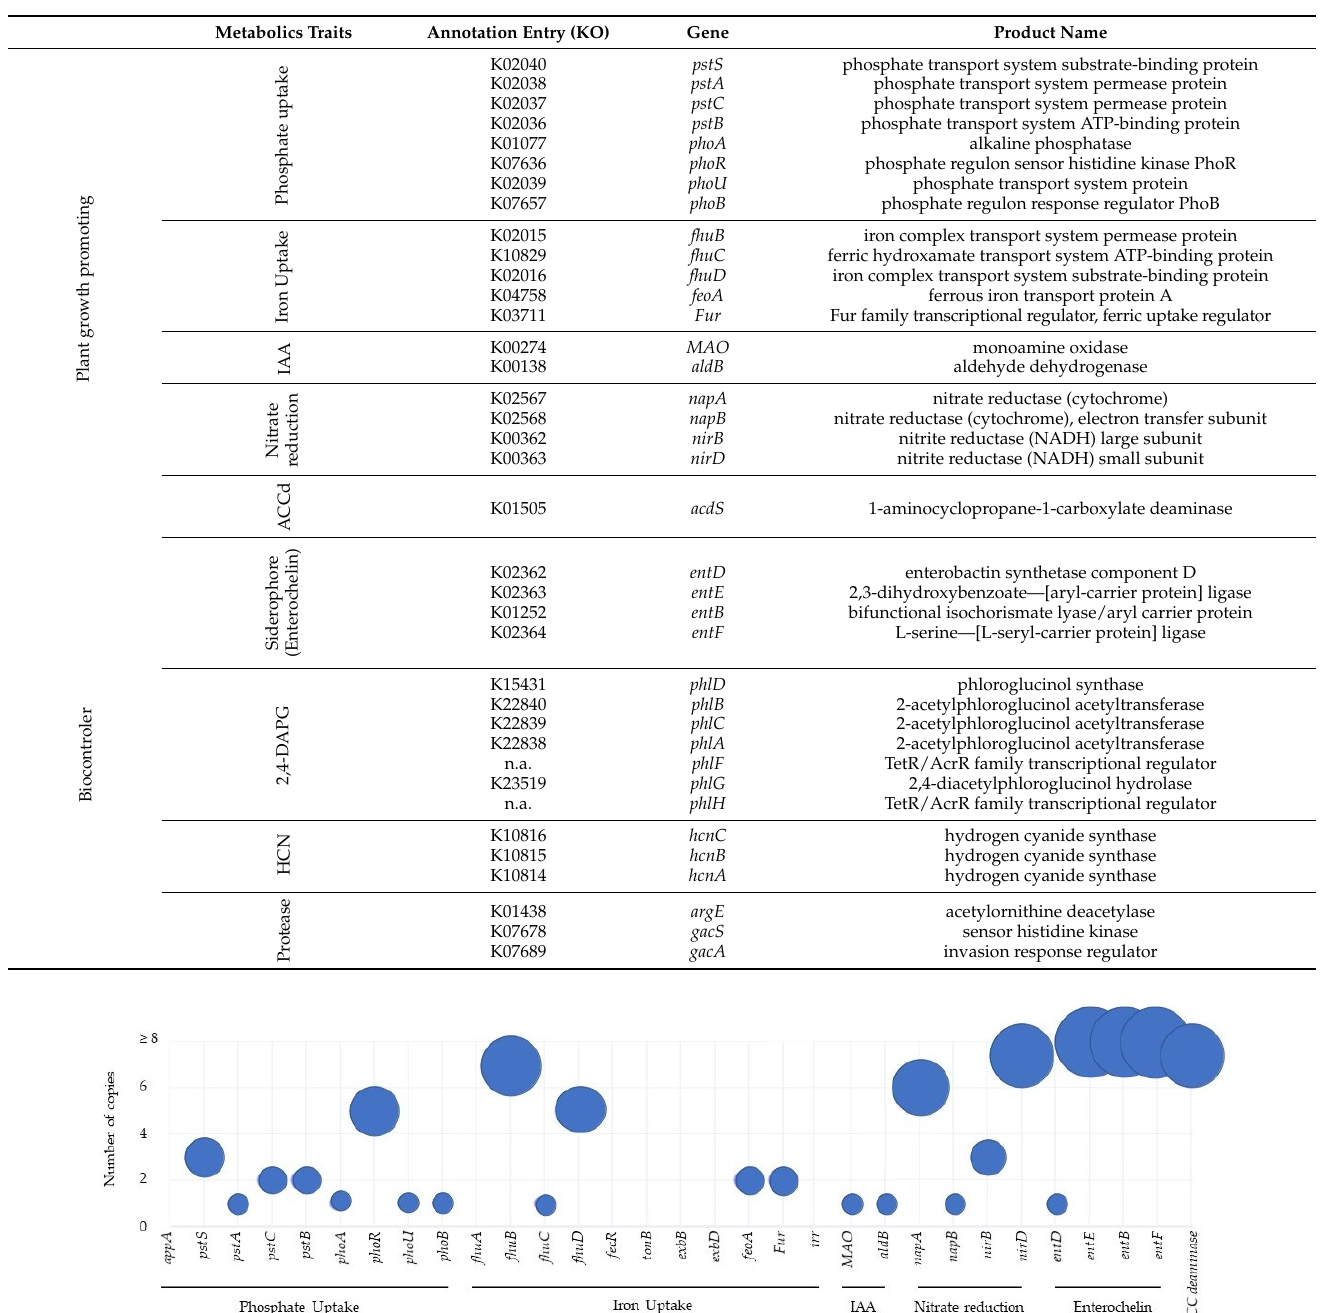
Figure 4. Different copies of genes involved in specific metabolic pathways associated with plant growth-promoting traits found in the genome of Pseudomonas sp. strain C3 through KEEG orthology and KofamKOALa databases.